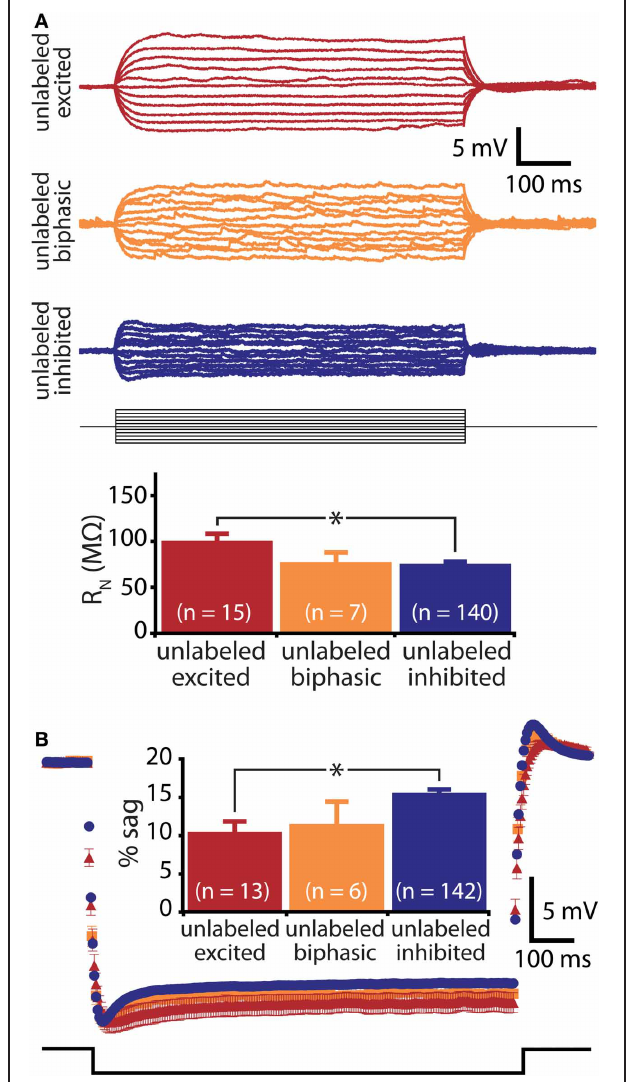
FIGURE 2 | Responsiveness to serotonin correlates with membrane physiology. (A) Top, voltage responses to somatic current injections ( − 50 to 50pA in 5pA steps) in unlabeled L5PNs. Bottom, comparison of input resistance ( R N ) in neurons having different responses to serotonin. (B) Average ( ± SEM) voltage responses to hyperpolarizing current injections sufficient to generate a peak hyperpolarization of ∼ 20mV in unlabeled L5PNs grouped according to their responsiveness to serotonin (blue indicates serotonergic inhibition, red indicates serotonergic excitation, and orange indicates biphasic responses). Comparison of results is inset. Asterisks indicate p < 0 .